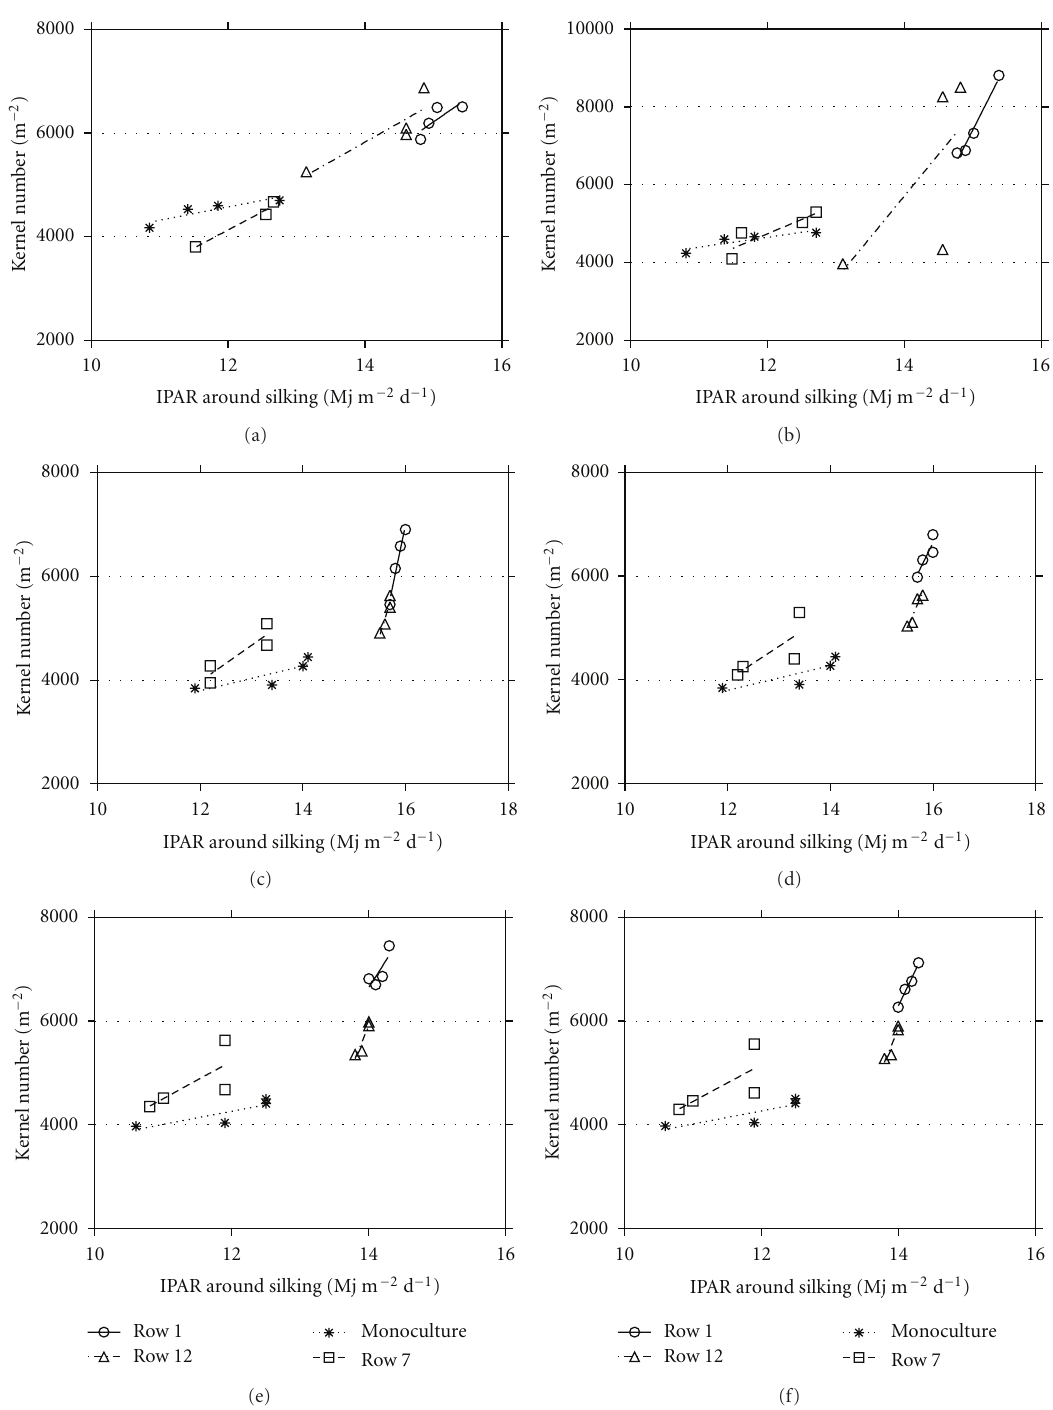
Figure 5: Number of corn grains per unit area in relation to IPAR around flowering in monoculture and in rows 1, 7, and 12 in corn-soybeans MG III strips, during C1 (a), C2 (c), and C3 (e) and in corn-soybeans MG V strips, during C1 (b), C2 (d), and C3 (f).